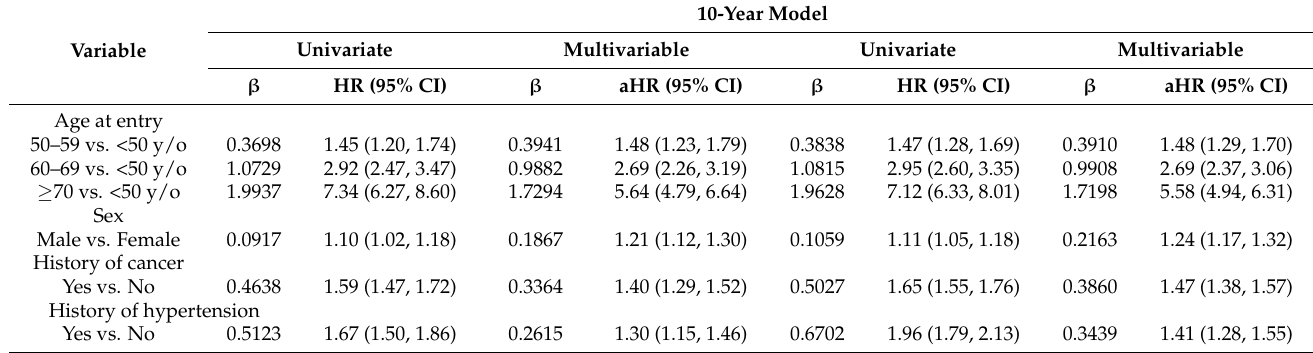
Table 2. Results from univariate and multivariable Cox regressions predicting all-cause mortality. Among persons with type 2 diabetes